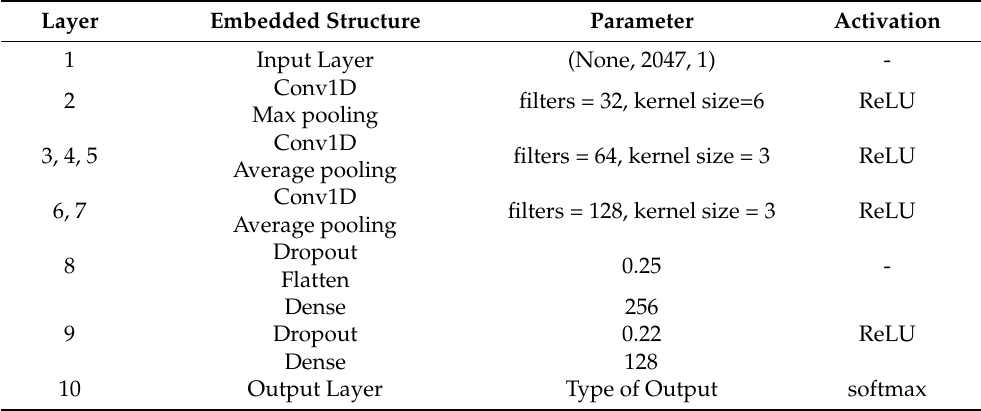
Table 2. UAV Identification and Classification